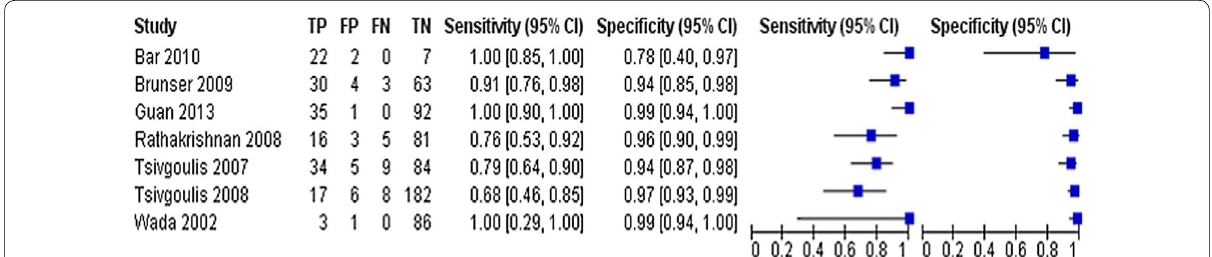
Fig. 2 Forest plot. Estimated diagnostic accuracy of transcranial ultrasonography in detecting steno-occlusive lesions in acute stroke